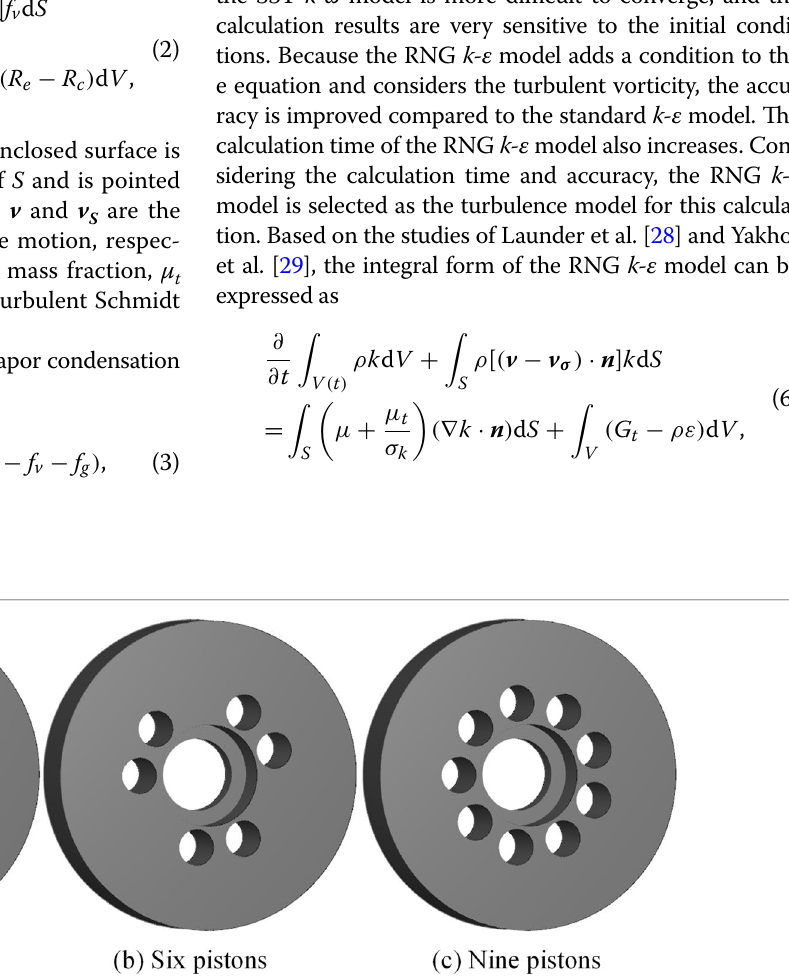
Figure 3 Fluid zone around the